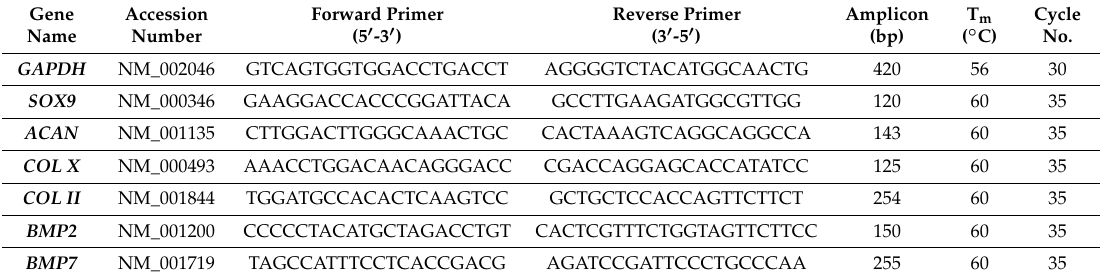
Table 1. List of used primers, product lengths, annealing